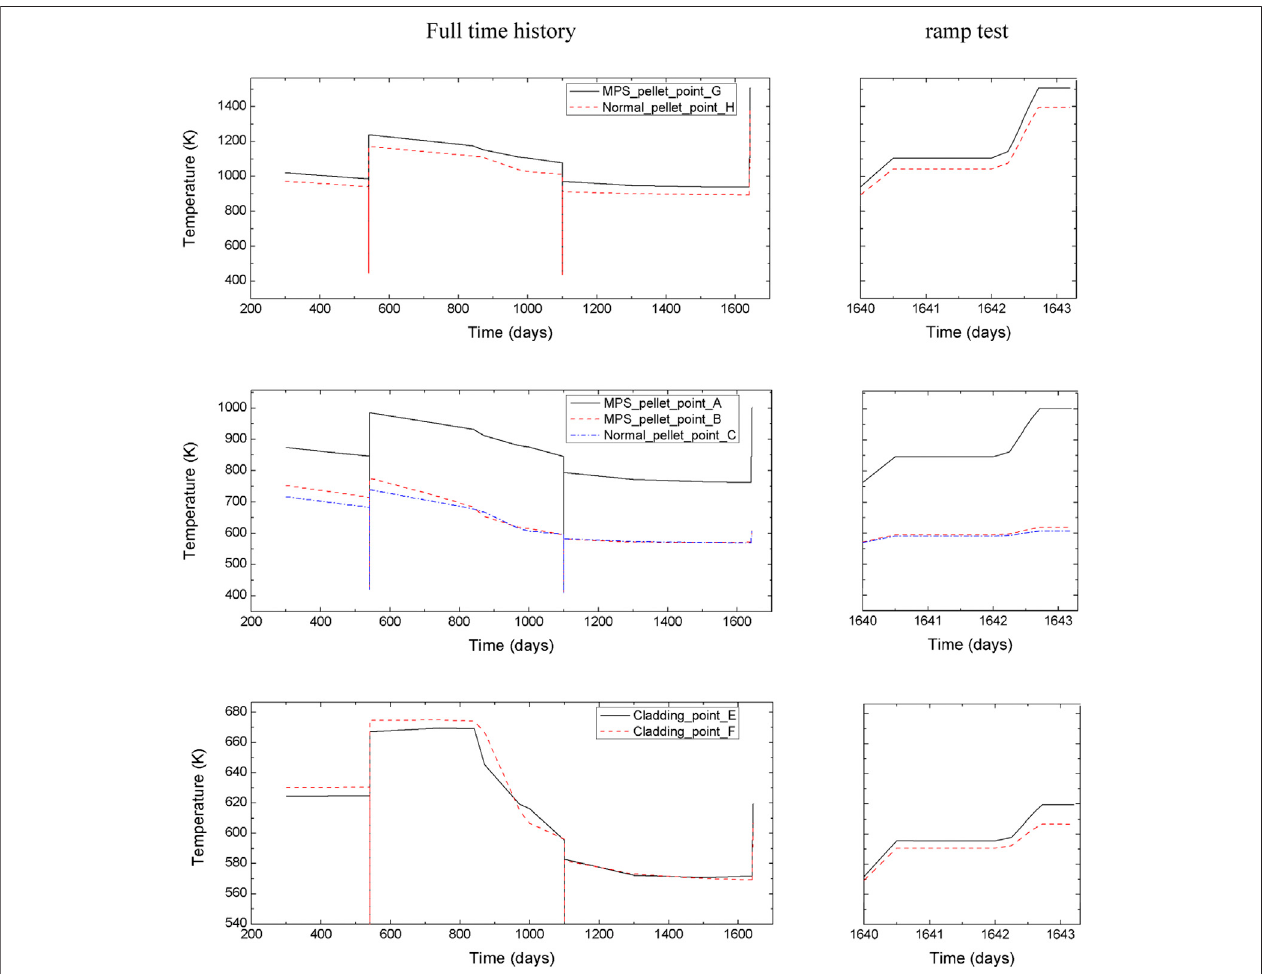
FIGURE 11 | Time history of temperature at pre-set points showing a comparative way with MPS defects and no defect pellet.